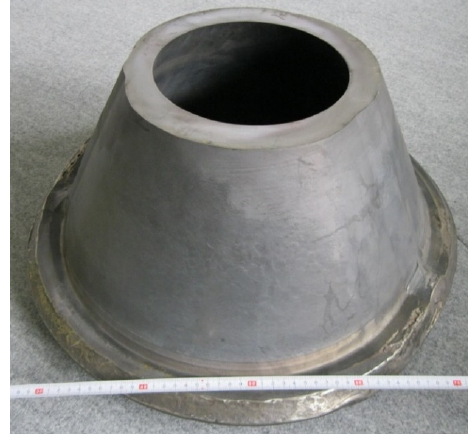
Figure 10. Formed simulated product after hot-pressing (top cut).